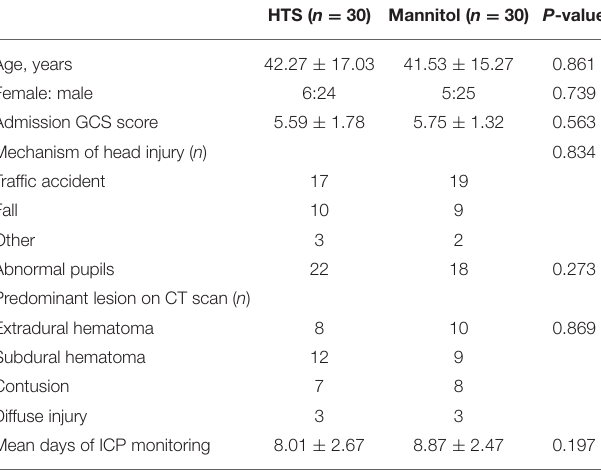
TABLE 1 | Demographic characteristics.